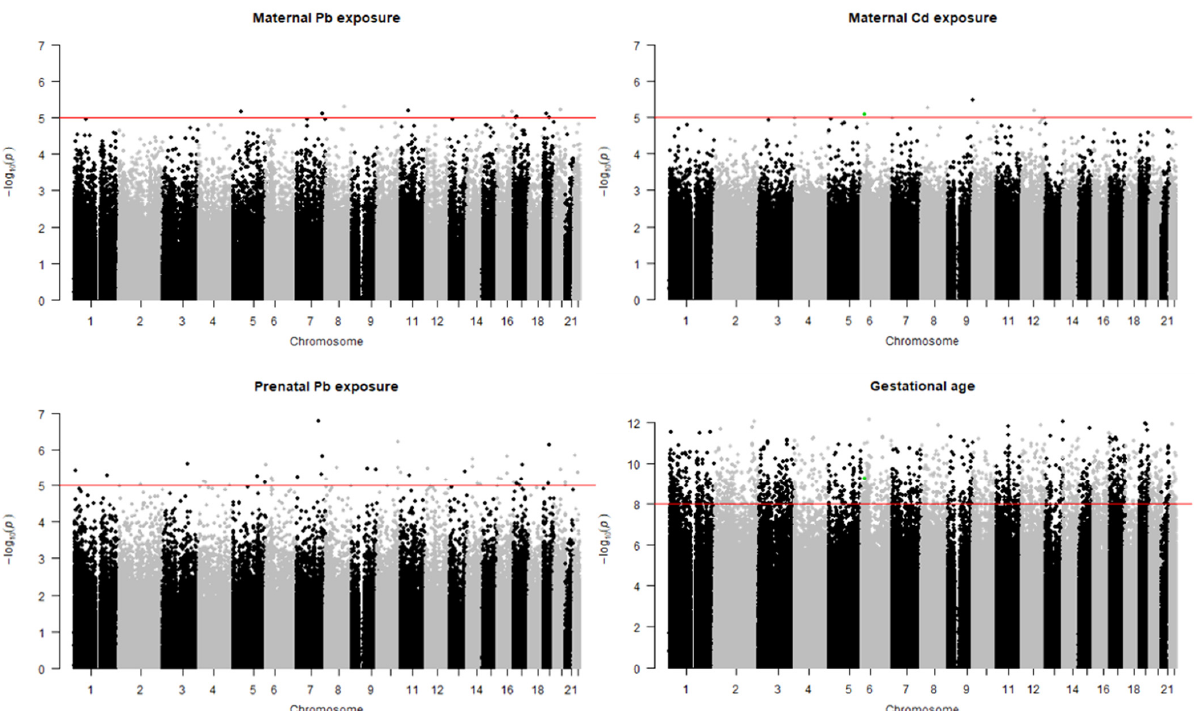
Figure 2. Manhattan plots for differentially methylated positions according to gestational age, birth weight, maternal Pb and Cd, and prenatal Pb exposure in order. Green dots in both gestational age and maternal Cd exposure indicate cg21010642.